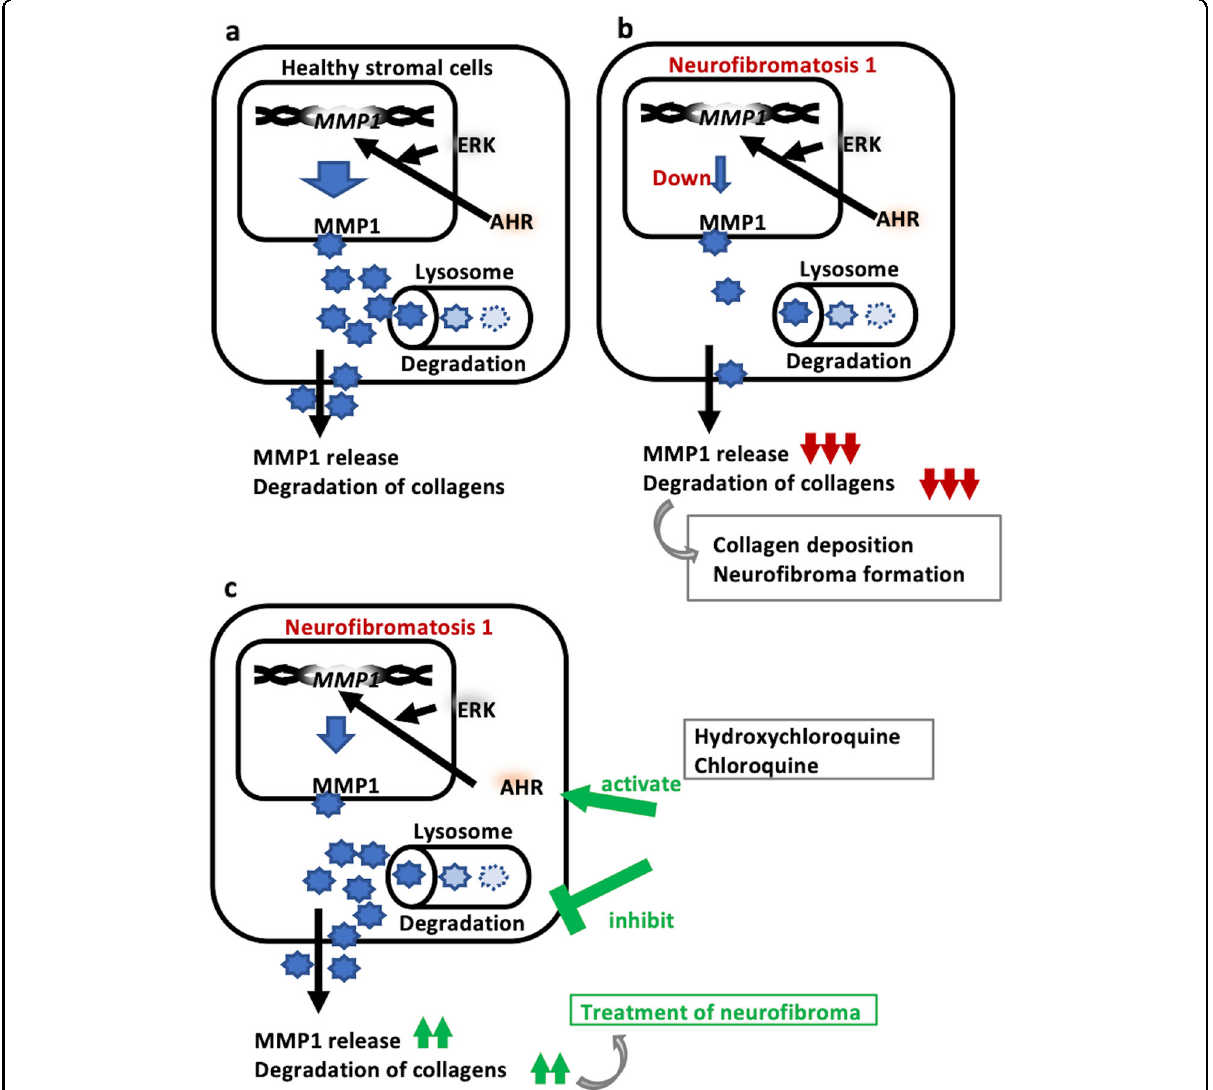
Fig. 7 Schematic image of MMP1 induction by HCQ in neuro fi bromatosis type 1 patients. Schematic summarizing of MMP1 induction by HCQ and CQ in NFFs. a , b MMP1 reduction reads collagen accumulation and generates or worsen neuro fi bromas in neuro fi bromatosis 1 patients. c AHR activated by HCQ or CQ induces ERK phosphorylation and MMP1 expression. At the same time, HCQ and CQ inhibit lysosomal degradation of